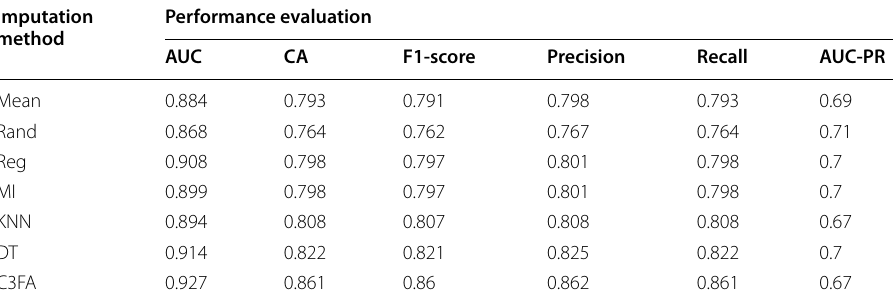
Table 2 Evaluation results using AUC, accuracy, F1-score, precision, recall, and AUC-PR for imputation